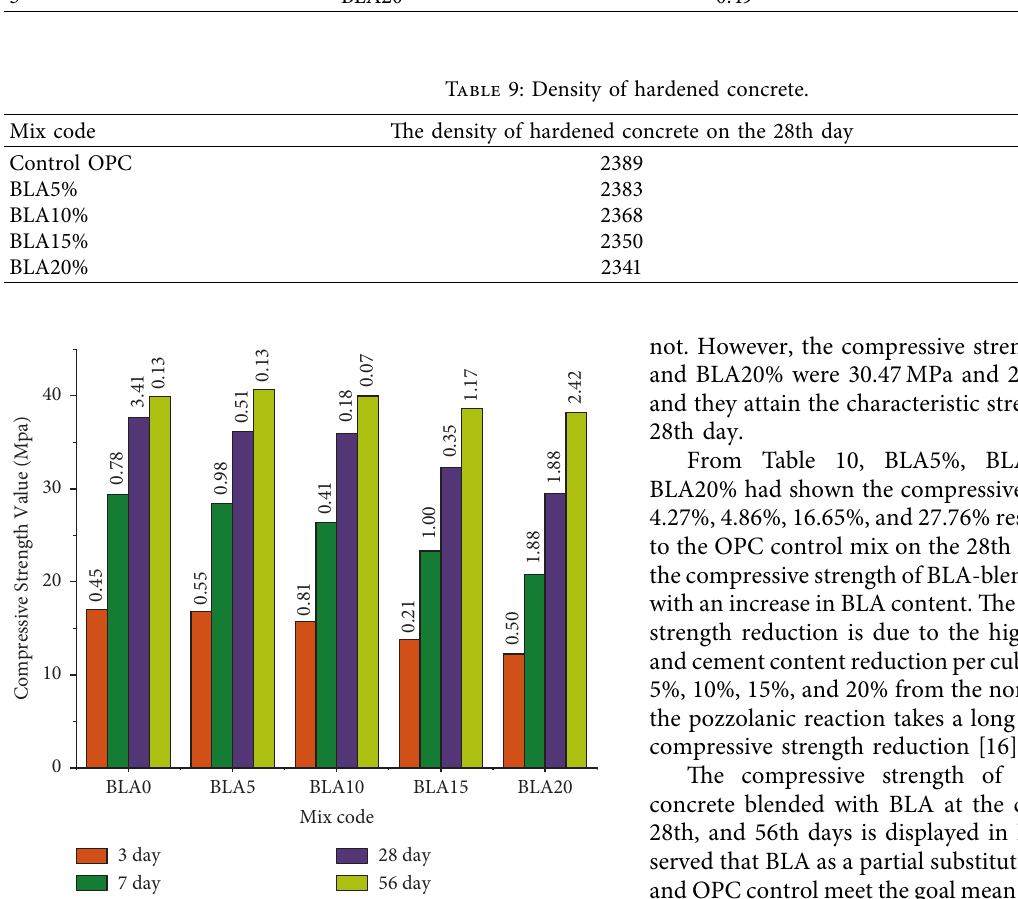
Figure 2: Compressive strength results for 3rd, 7th, 28th, and 56th days.